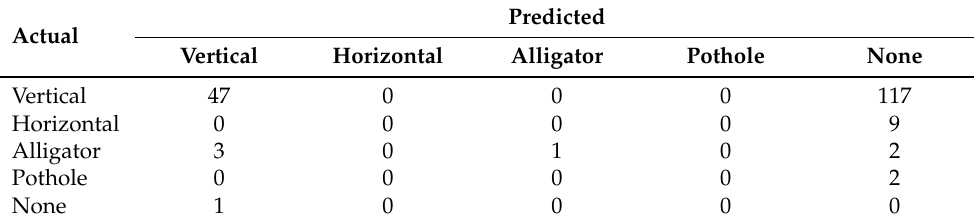
Table 12. Confusion matrix of Model 6.